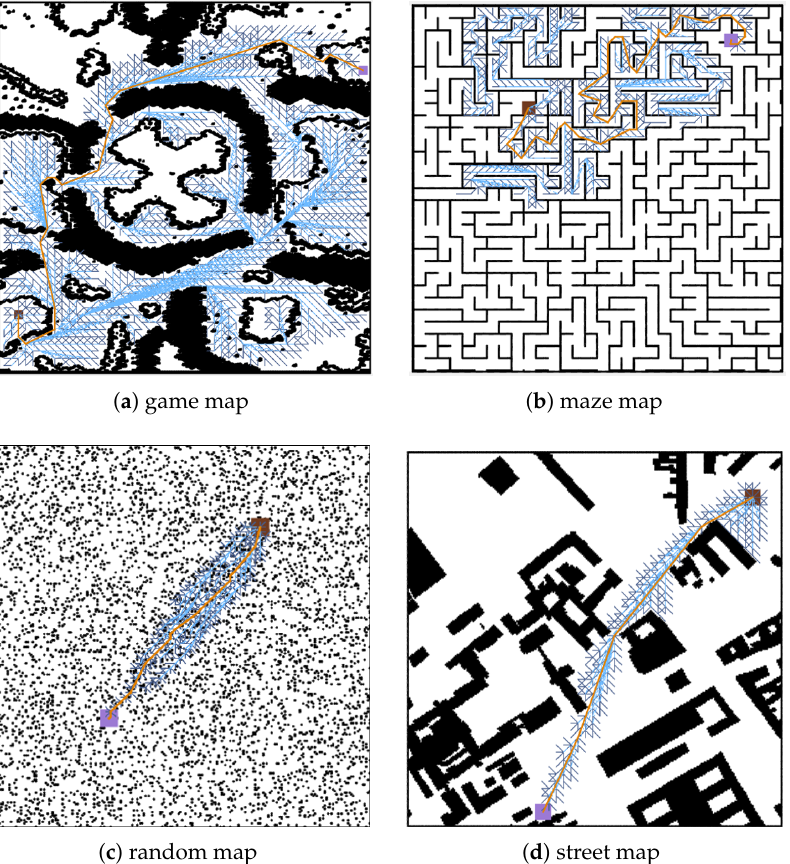
Figure 5. Extension processes of LLA* on four different kinds of benchmark maps: game map ( a ), maze map ( b ), random map ( c ), and street map ( d ). Orange lines represent the final paths, and the blue lines are new edges after